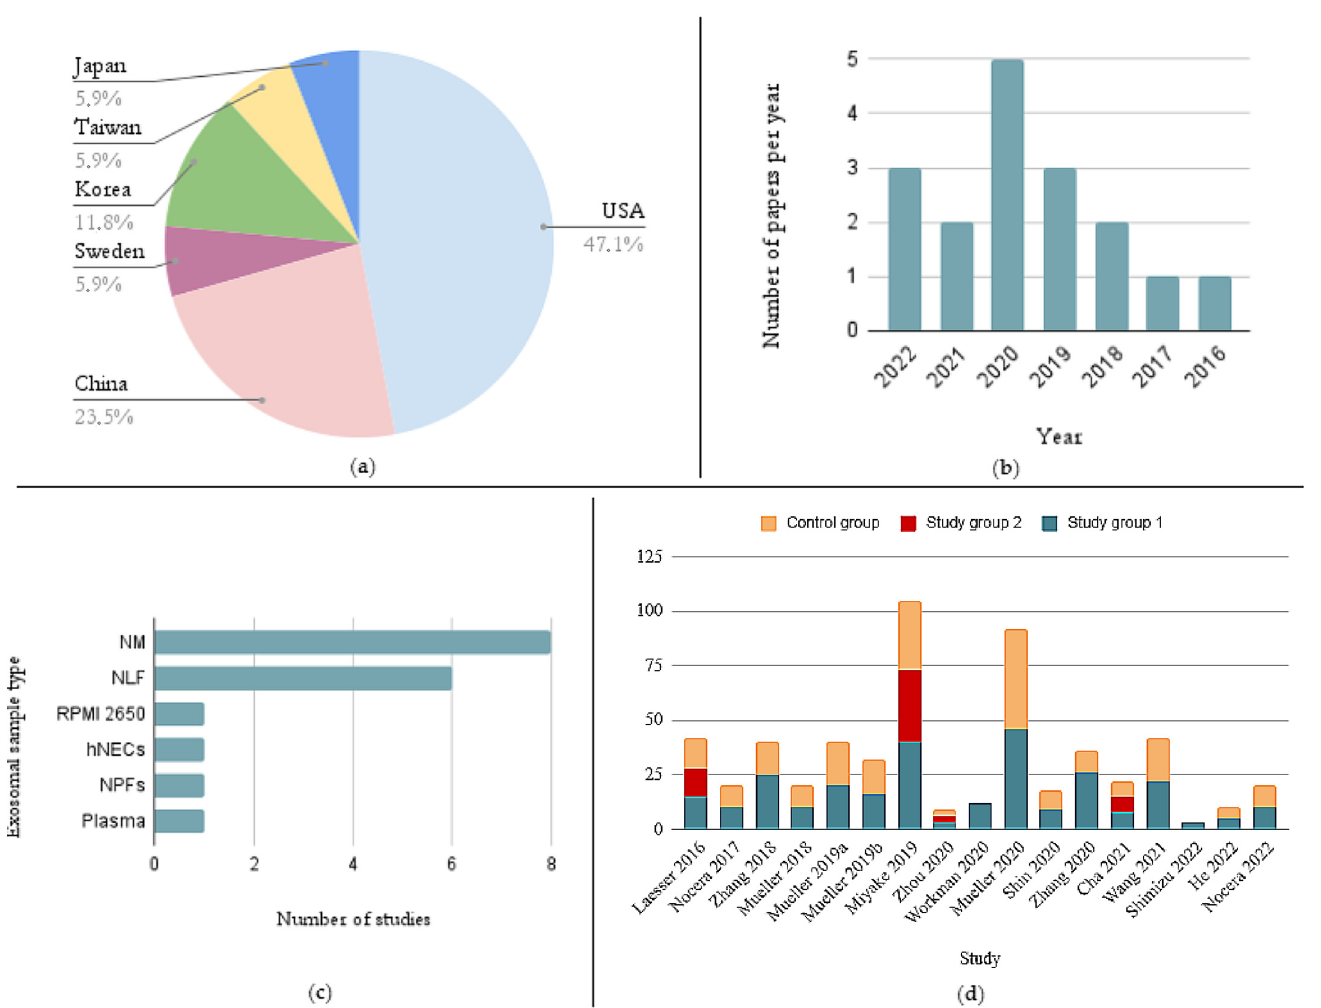
Figure 2. Basic information about retrieved papers. ( a ) Countries where the selected studies have been performed. ( b ) Number of papers concerning exosomes in CRS per year. ( c ) Use of particular exosomal samples in included studies. ( d ) Group sizes in the included studies [8,12–27] (2019a [15], 2019b [16]).